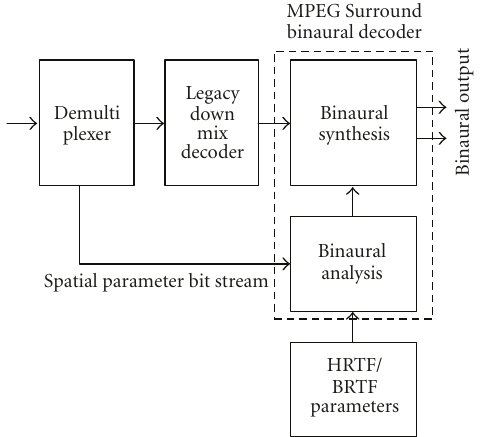
Figure 5: Overview of a binaural decoding mode for MPEG Surround.